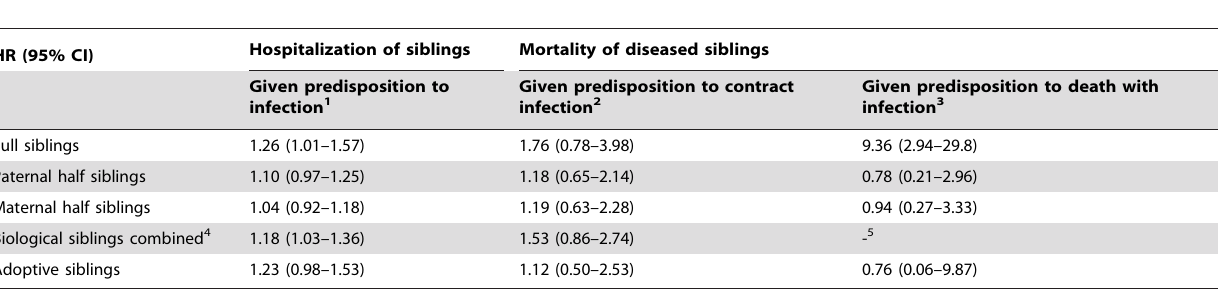
Analyses are stratified by sex of adoptee and sibling, and by birth year group of adoptee and sibling. Siblings of the same adoptee are analysed in one model allowing for correlation between